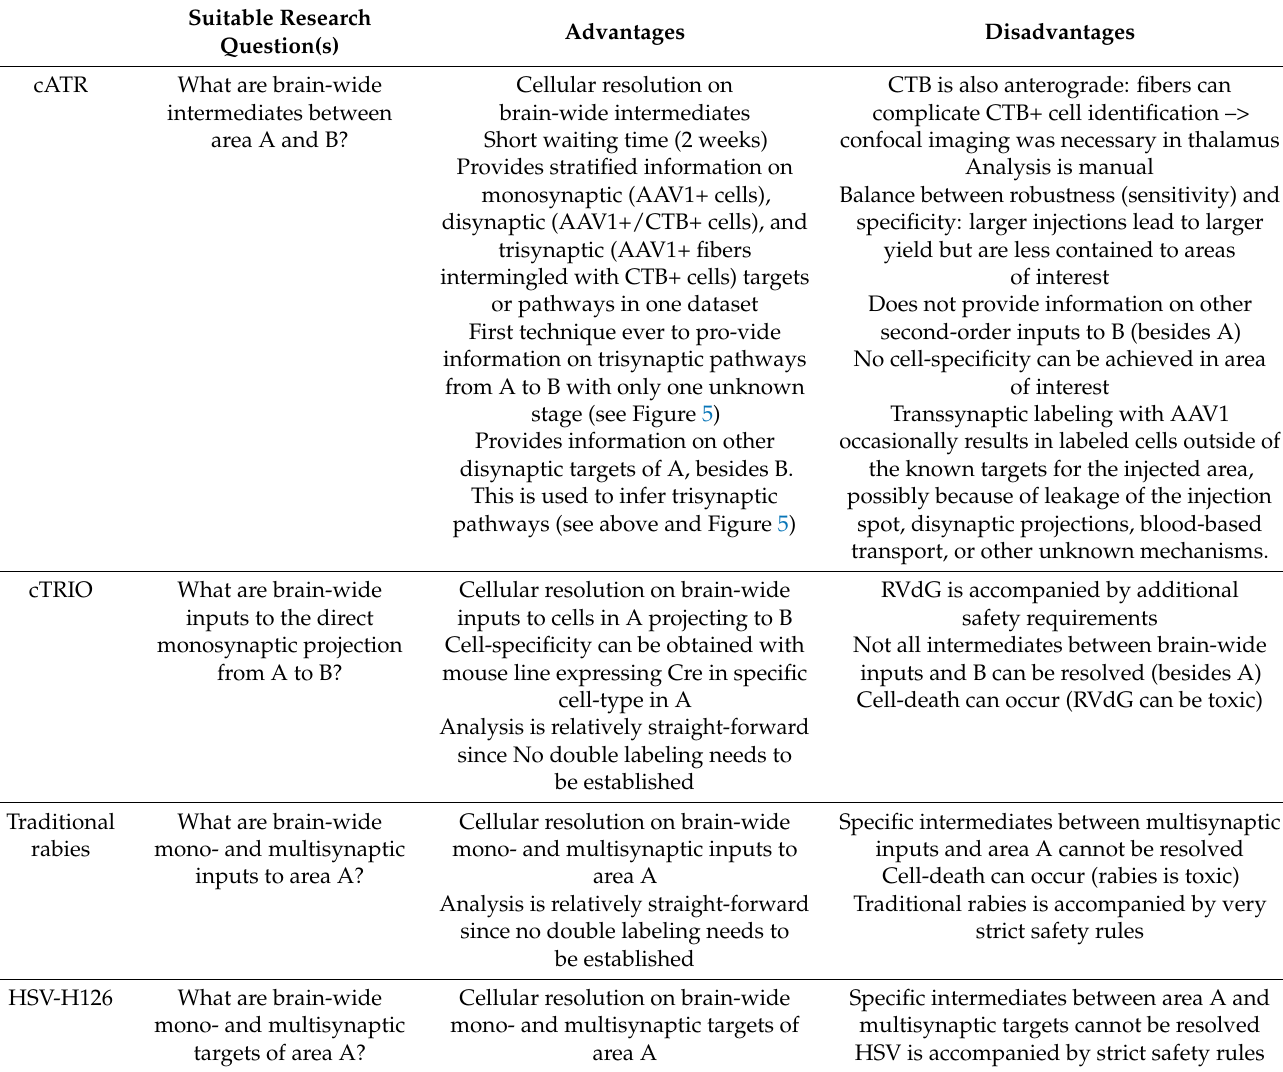
Table 1. Advantages and disadvantages of cATR compared to other well-known multi-synaptic tracing